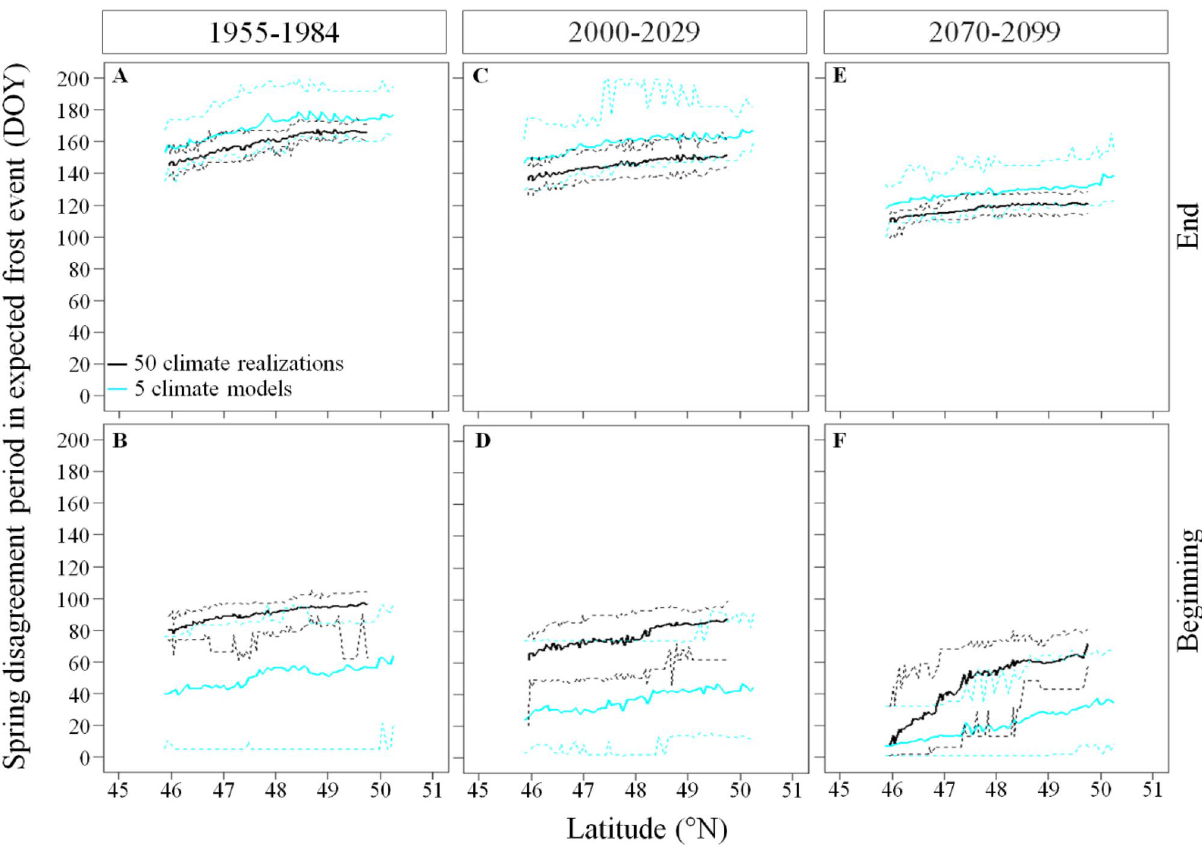
Figure 5. Inter- and intra-climate model variability in the day of year of the beginning and end of the disagreement period in expected frost occurrence during spring across latitudes and 30-year periods. Solid lines represent the mean, and dashed lines the maximum and minimum DOY determining the beginning and end of the disagreement period in expected frost occurrence across latitudes. The disagreement period in expected frost occurrence refers to the period when the percentage of climate simulations expecting the occurrence of frost are < 90% and > 10% for the intra-climate model (internal variability) analysis and are < 80 and > 20% for the inter-climate model (difference between model formulations) analysis since it is during this period that climate simulations diverge the most in their expected frost occurrence. We used the ggplot2 library developed by Wickham 27 to produce the